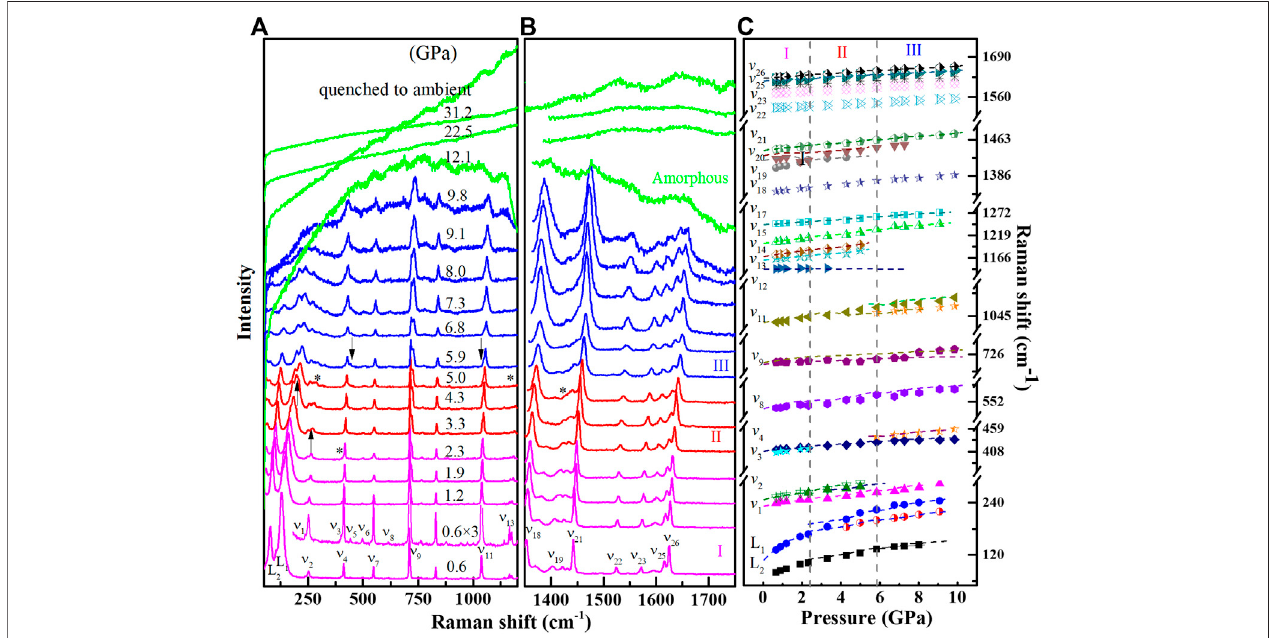
FIGURE 1 | High pressure Raman spectra of phenanthrene up to 31.2 GPa. (A) Selective Raman spectra in the frequency range of 50 – 1200 cm ₋ 1 . (B) Selective Ramanspectrainthefrequencyrange of1350 – 1750cm ₋ 1 . (C) Pressure dependence ofthe Ramanshiftfor theobserved modes. Thedashed lines areresultsfrom Ref. 14.Dashed verticallines represent phaseboundaries, andphasesareassignedwithRomannumbers. Theupperarrows andasterisksdenotethenewappearanceand the disappearance of peaks, respectively.